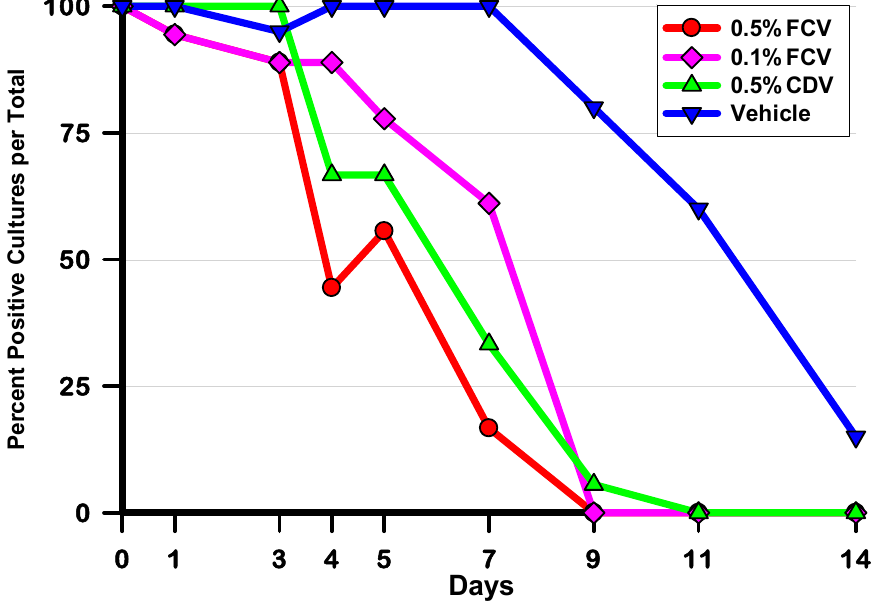
Figure 4. Percentages of HAdV5-positive cultures per total for each treatment group and culture day. Significant differences were demonstrated on the following days: Day 4: (0.5% FCV = 0.5% CDV < VEH; 0.5% FCV < 0.1% FCV); Day 5: (0.5% FCV = 0.5% CDV = 0.1% FCV < VEH); Day 7: (0.5% FCV, 0.5% CDV, 0.1% FCV < VEH; 0.5% FCV < 0.1% FCV); Day 9: (0.5% FCV = 0.1% FCV = 0.5% CDV < VEH); Day 11: (0.5% FCV = 0.1% FCV = 0.5% CDV <